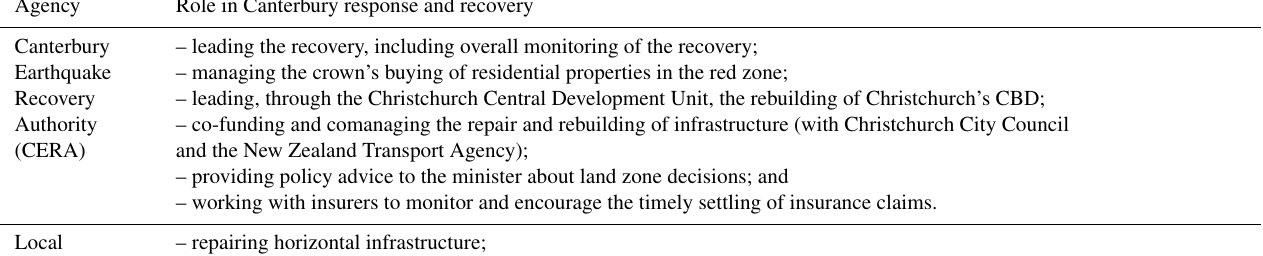
Table 1. Summary of agency roles and responsibilities at the time of the CES initiation (Controller and Auditor-General, 2012).